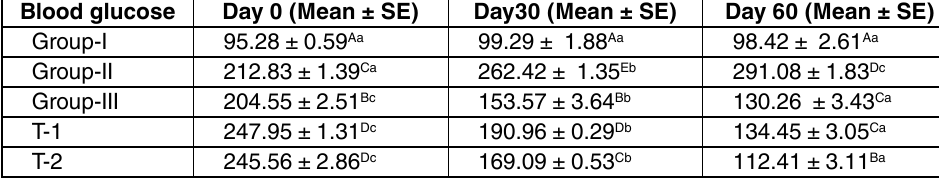
table 2. Blood glucose (mg/dl) levels in different treatment groups.